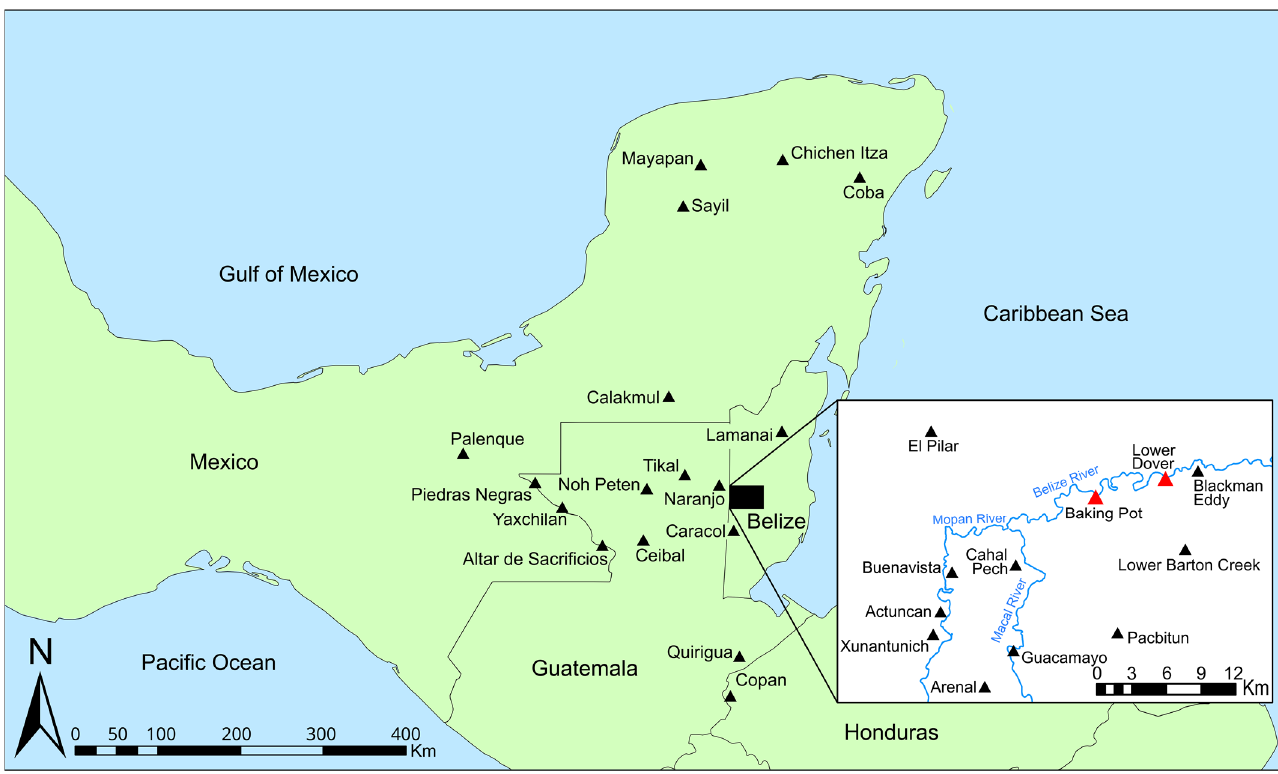
Figure 1. Map of Mesoamerica showing sites mentioned in the text and other important sites with an inset showing the Belize River Valley and the locations of Baking Pot and Lower Dover.